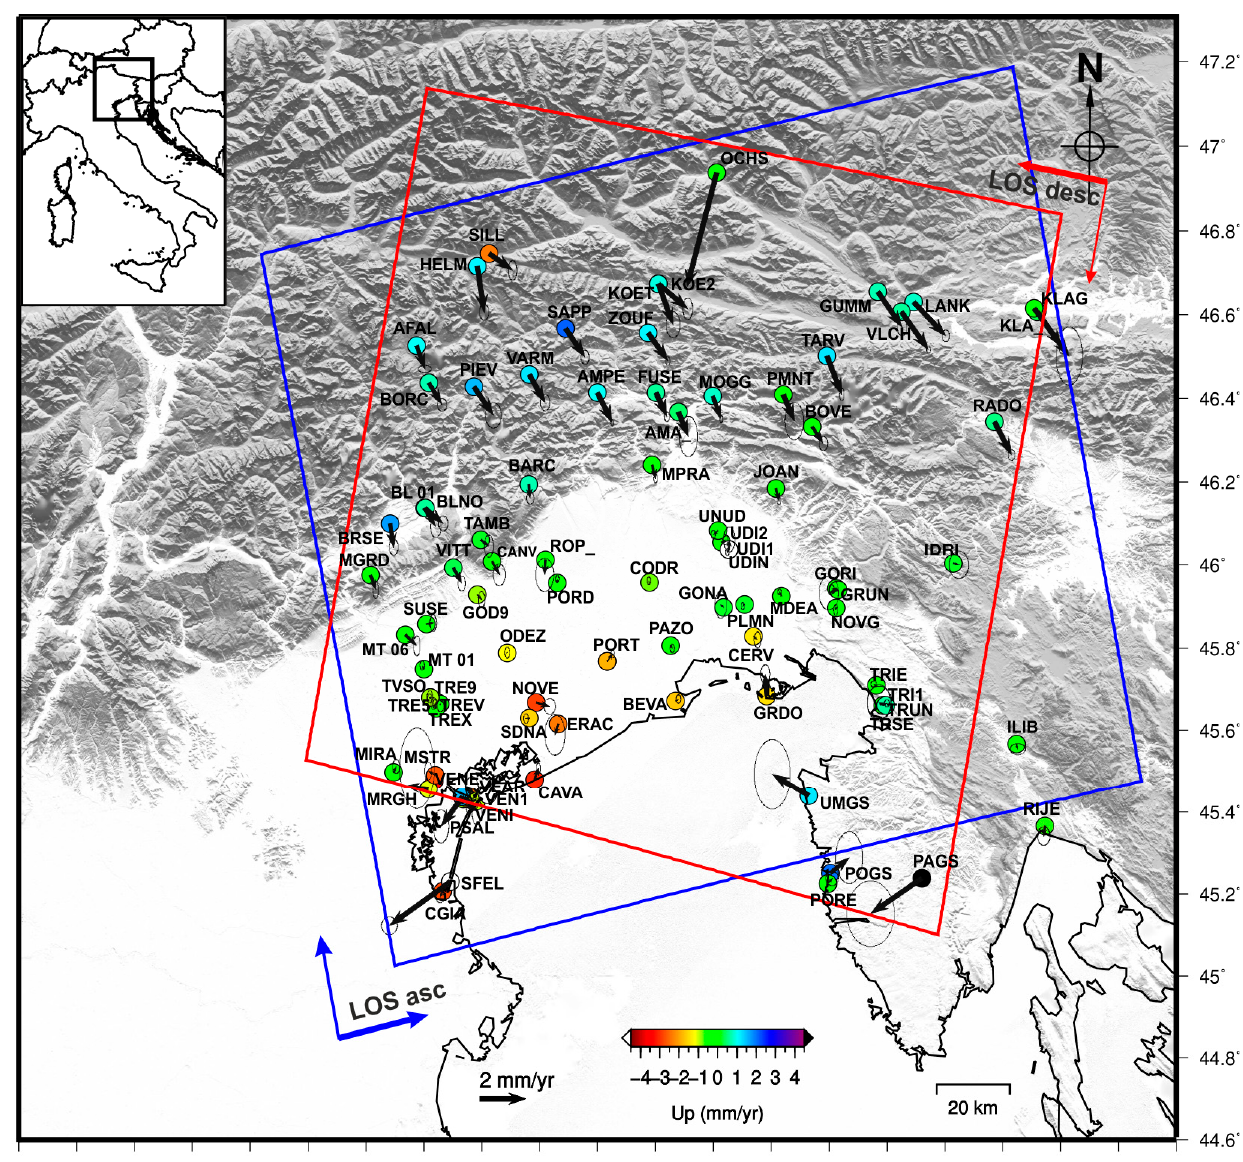
Figure 2. SAR and GNSS data. The map shows the area covered by the Sentinel-1 ascending (blue area) and descending (red area) orbit tracks. The arrows show the GNSS horizontal velocities in an Adria-fixed reference frame, considering the rotation pole from [15], whereas the colored points indicate the vertical velocity according to the color scale.